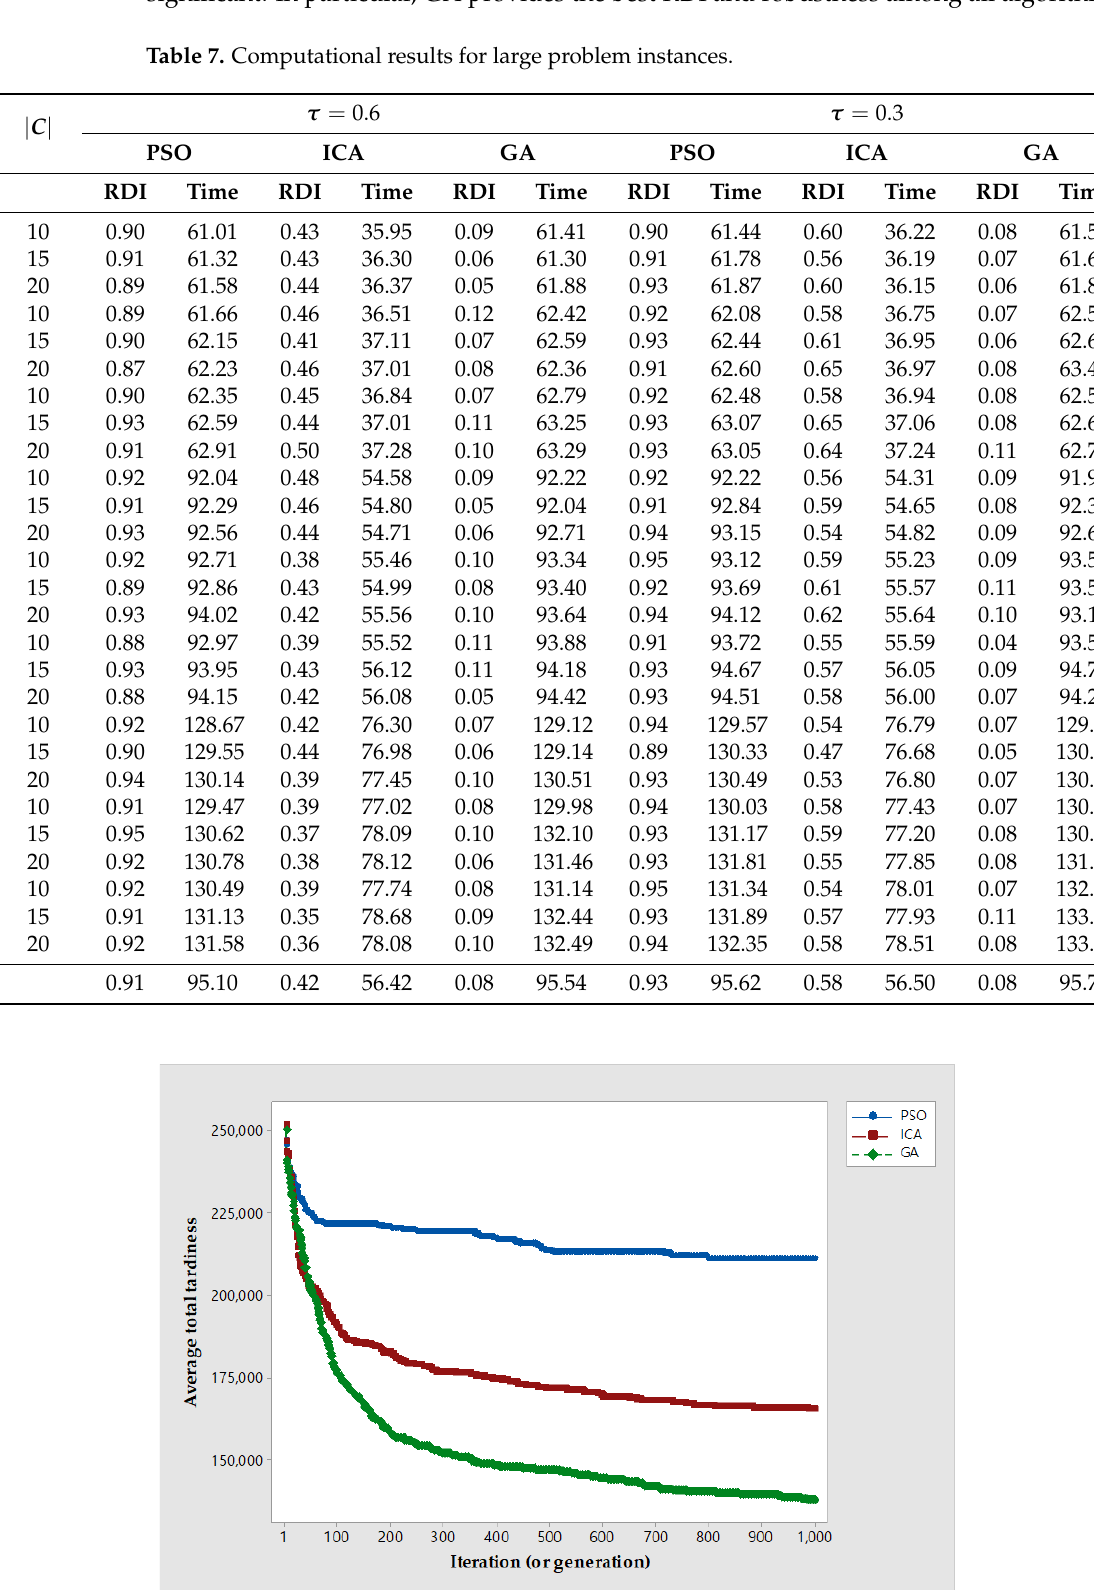
Figure 5. The convergence graph for PSO, ICA, and GA.